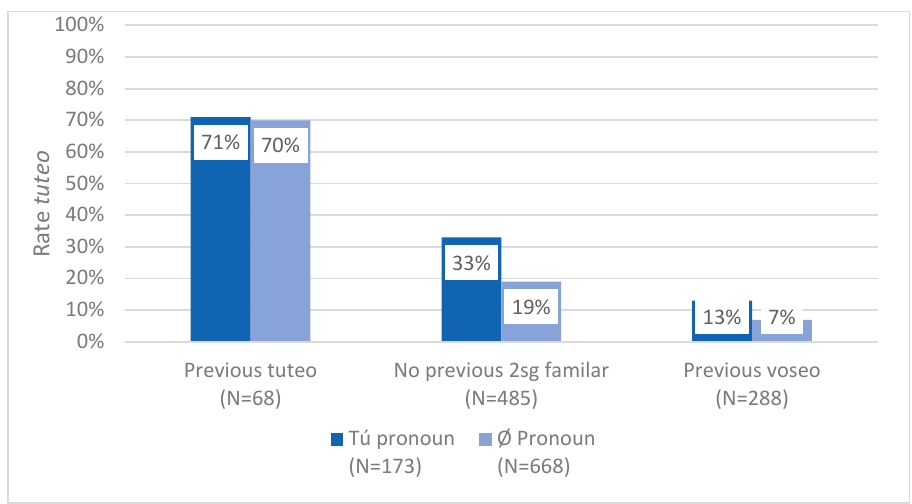
Figure 5. Rates of tuteo by previous realization and subject expression ( tú vs. Ø ).